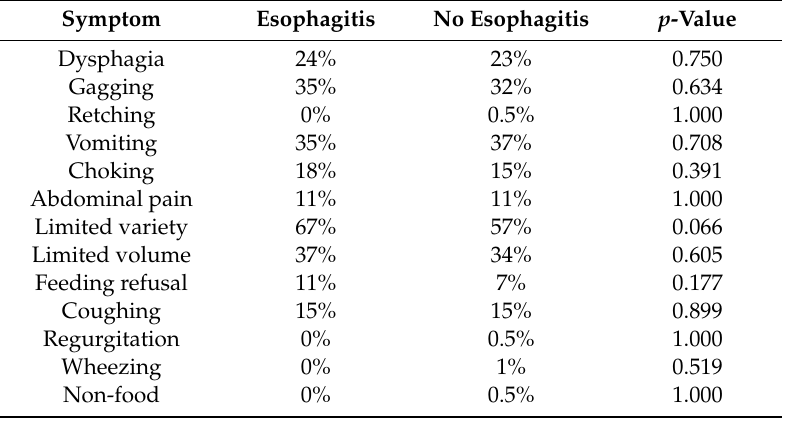
Table 4. Symptom frequencies of patients with and without